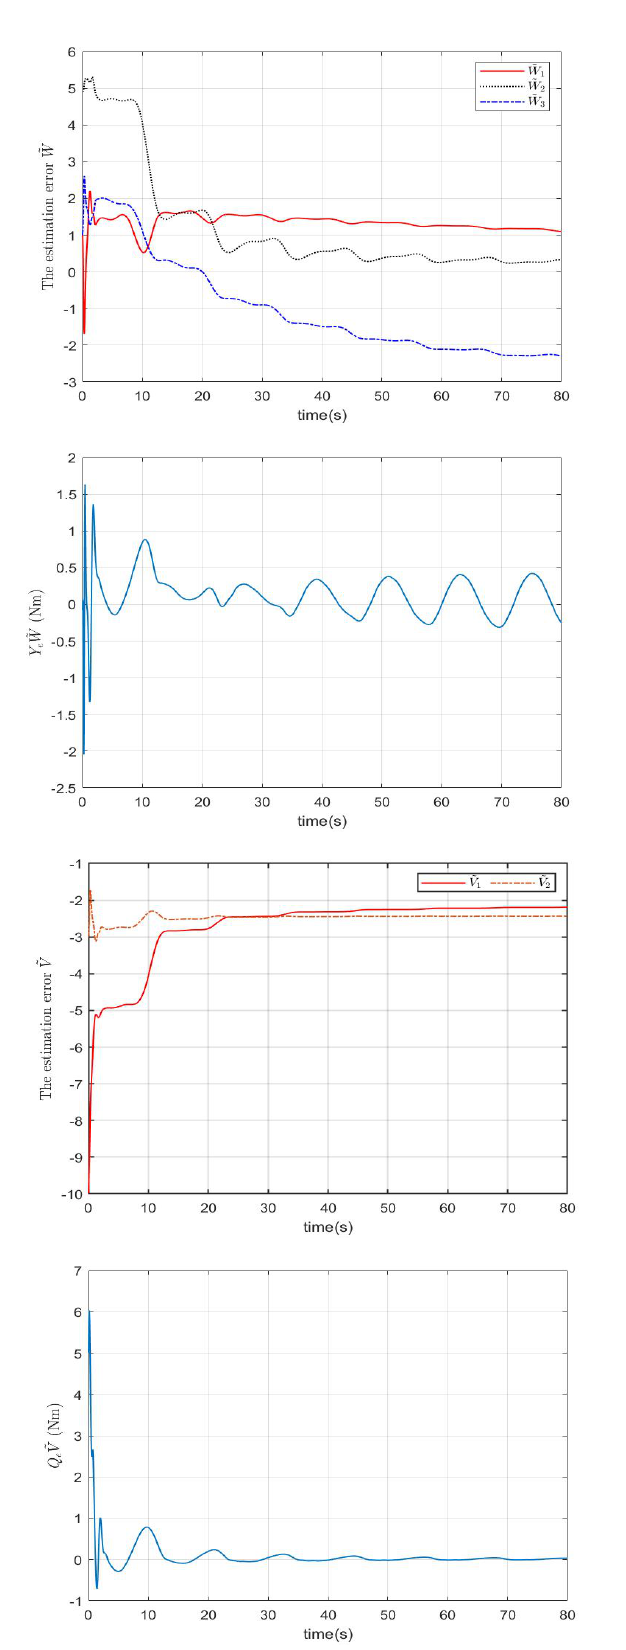
Figure 5. The estimation errors ˜ W , Y e ˜ W , ˜ V , and Q e ˜ V in Case